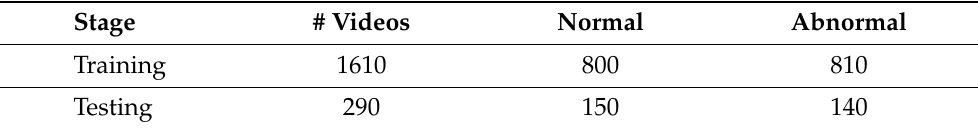
Table 1. Number of videos for training and testing, including normal and abnormal ones in UCF- Crime dataset.